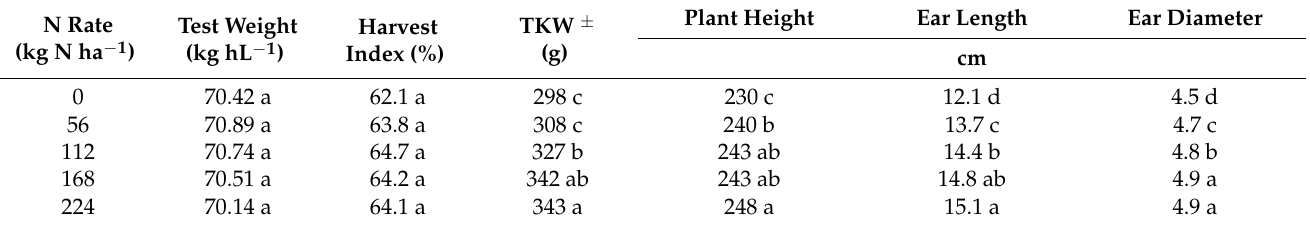
Table 4. The effect of N application rate on maize test weight, harvest index, thousand kernel weight (TKW), plant height, ear length and ear diameter when data analyzed over years (2019 and 2020) and N fertilizer application time at Swan Lake Research Farm, near Morris,